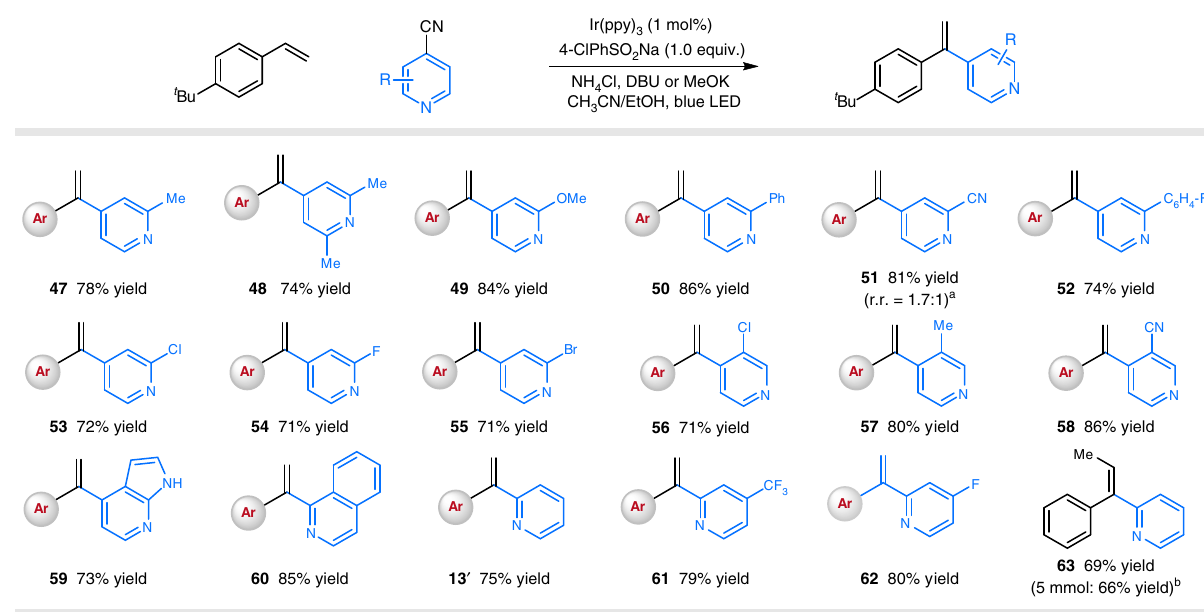
Fig. 4 Substrate scope of pyridines. Reaction conditions: Ir(ppy) 3 (1 mol%), 4-Cl-PhSO 2 Na (1.0 equiv.), styrene (0.2 mmol), cyanopyridine (2.0 equiv.), NH 4 Cl (2 equiv.), base (6 equiv.), MeCN/EtOH, 90 W blue light-emitting diode (LED, 40 °C, 2 h. All cited yields are isolated yields. a The ratio was determined by 1 H NMR analysis. b Reaction performed on a 5 mmol scale. see Supplementary Fig. 1 for details. Ar = 4- tert -butylphenyl